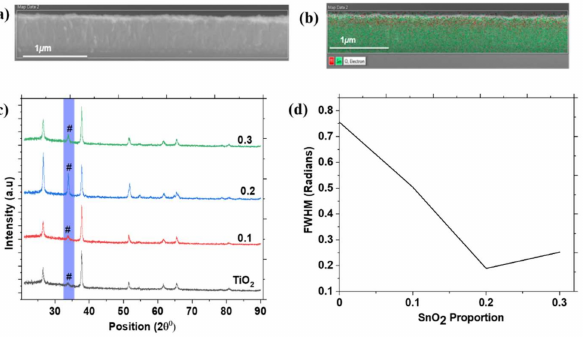
Figure 3. ( a ) SEM and ( b ) EDS Cross-sectional image of representative ETL film on FTO-coated glass; ( c ) XRD patterns of the ETL films ( d ) FWHM for the ETLs at different SnO 2